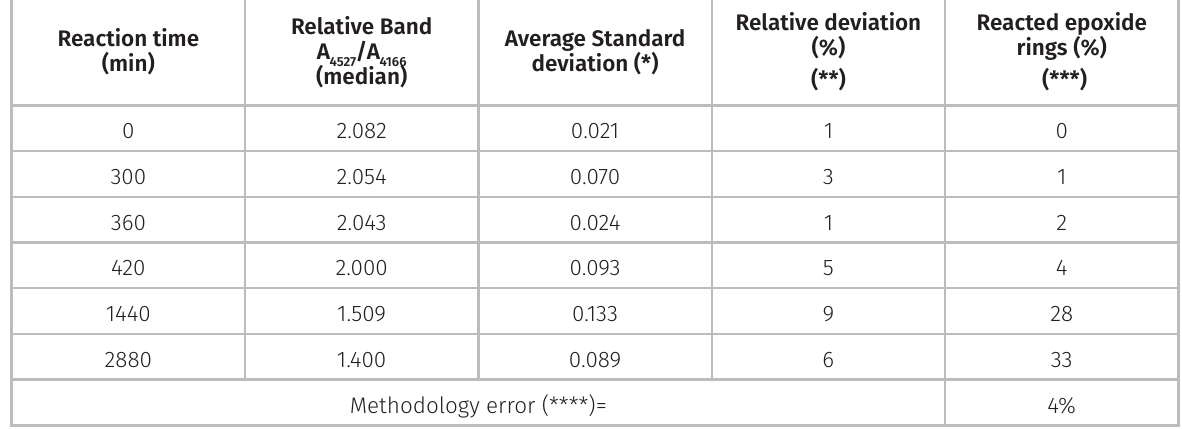
Table III. Resumed NIRA/transflectance (A Reaction time (min)